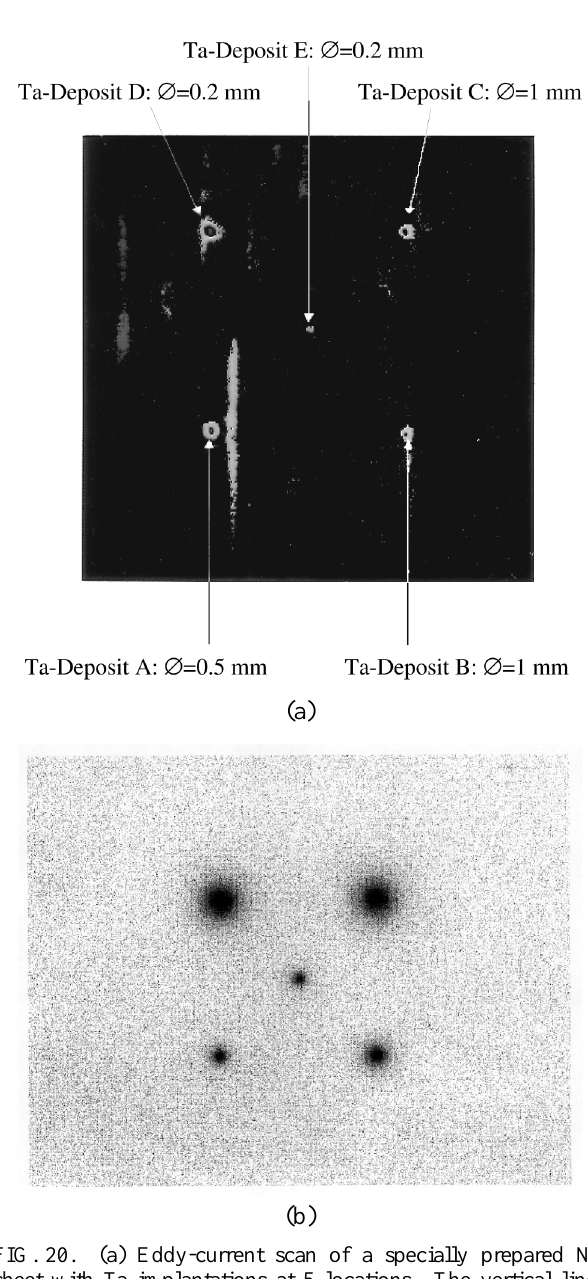
FIG. 20. (a) Eddy-current scan of a specially prepared Nb sheet with Ta implantations at 5 locations. The vertical lines are caused by microphonics. (b) Neutron activation analysis of the same